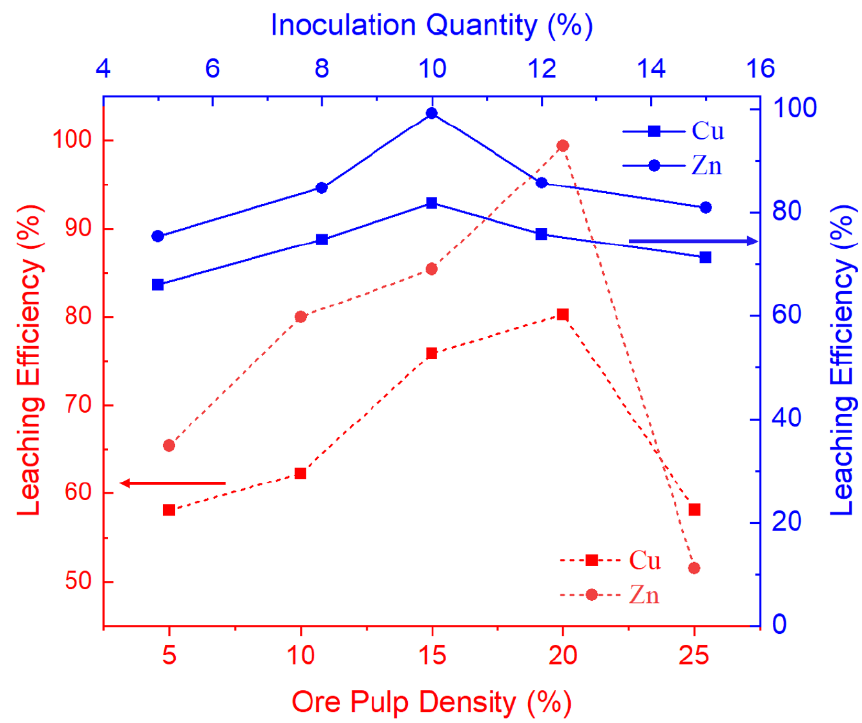
Figure 5. Leaching efficiency curves determined by ore pulp density and inoculation quantity.